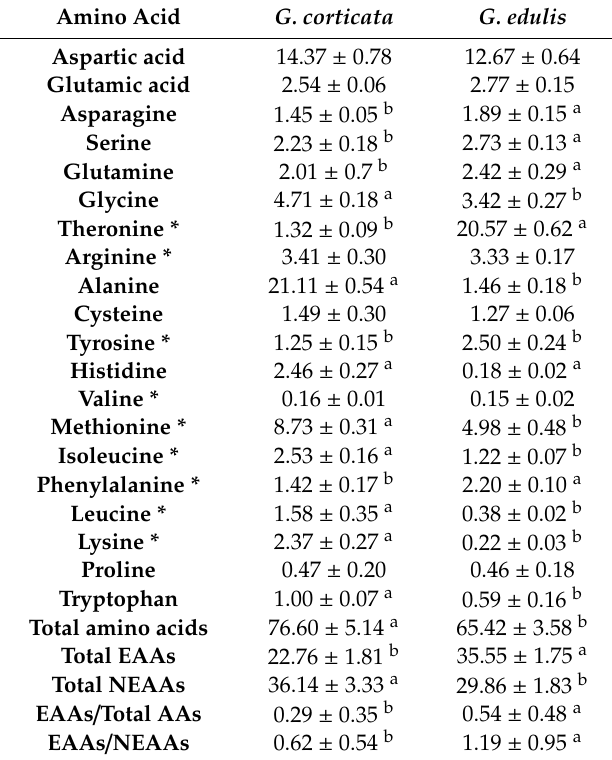
Table 3. Protein composition of G. corticata and G. edulis .